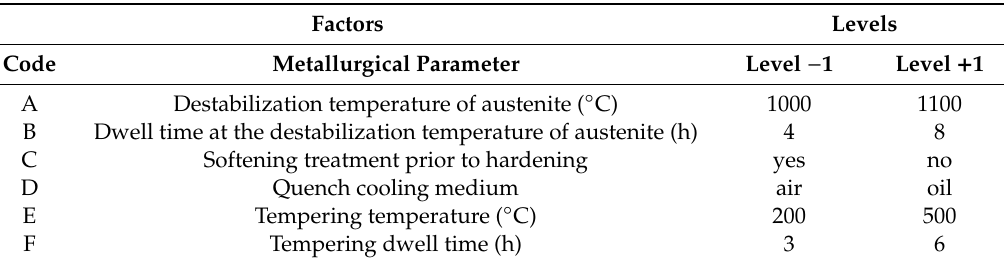
Table 2. Factors and Levels.